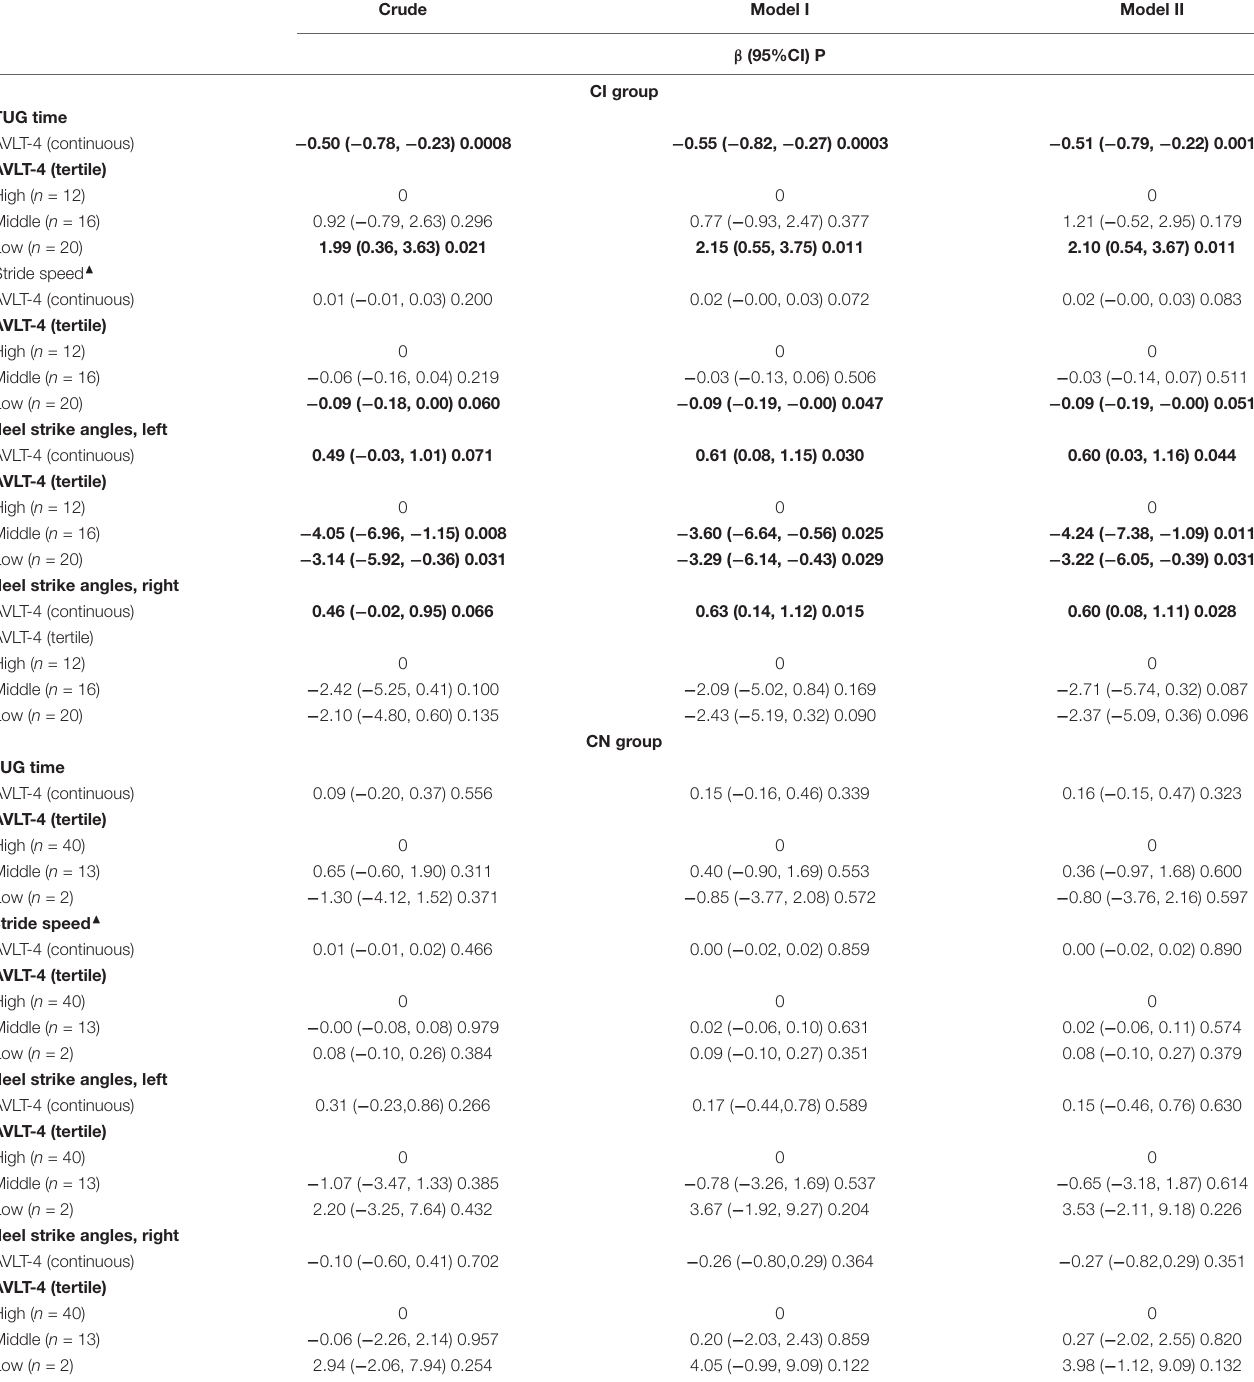
TABLE 2 | Association between short delayed memory (SDM) and fall risk in different groups